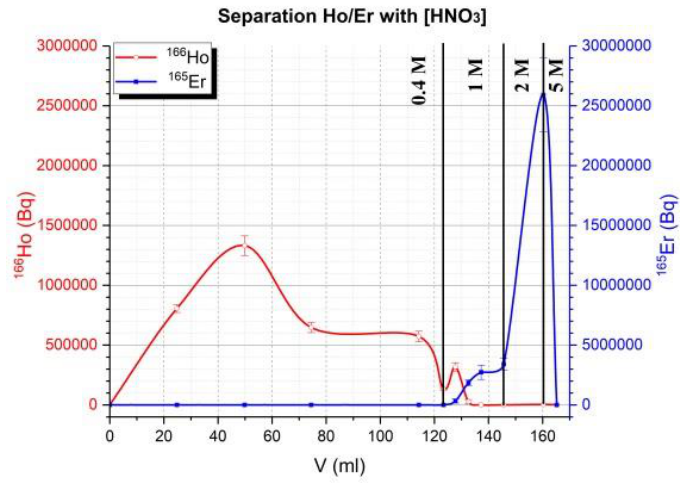
Figure 7. Profile of elution 165 Er/ 166 Ho of sample 3.